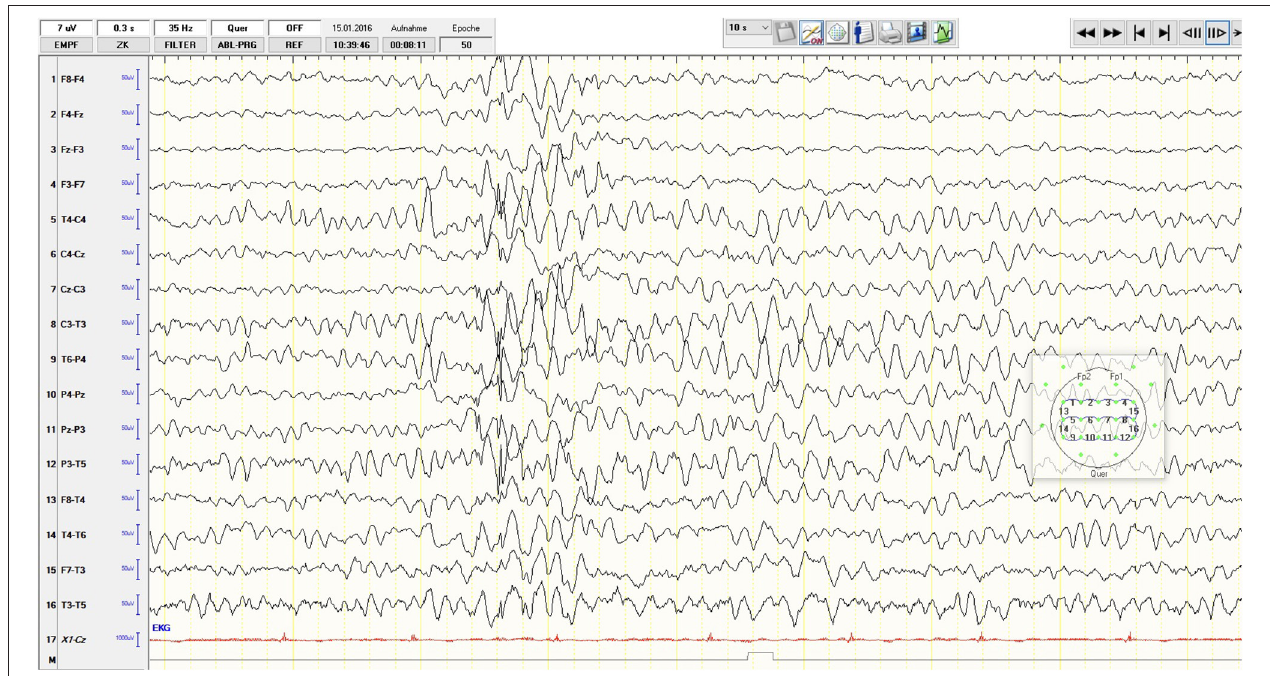
FIGURE 3 | Sixteen-channel EEG recording, low-pass filter 35 Hz: desynchronize alpha-rhythm (7–10Hz) with a high amplitude (60–150 µ V); generalized irregular spikes and sharp waves and occasional theta-rhythm activity.